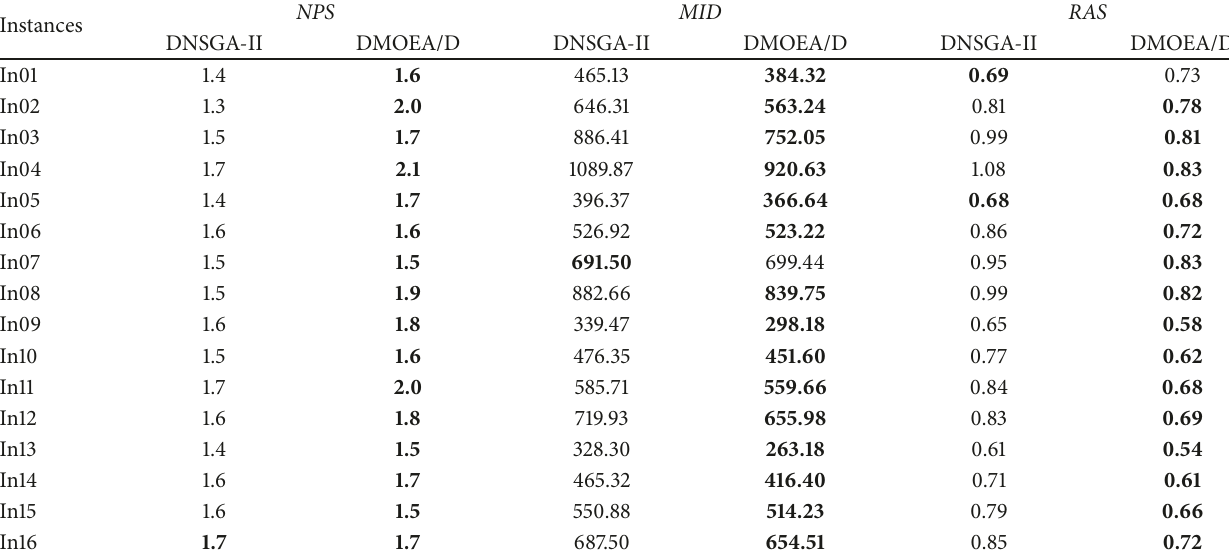
Table 6: Scheduling results of 2-objective problem